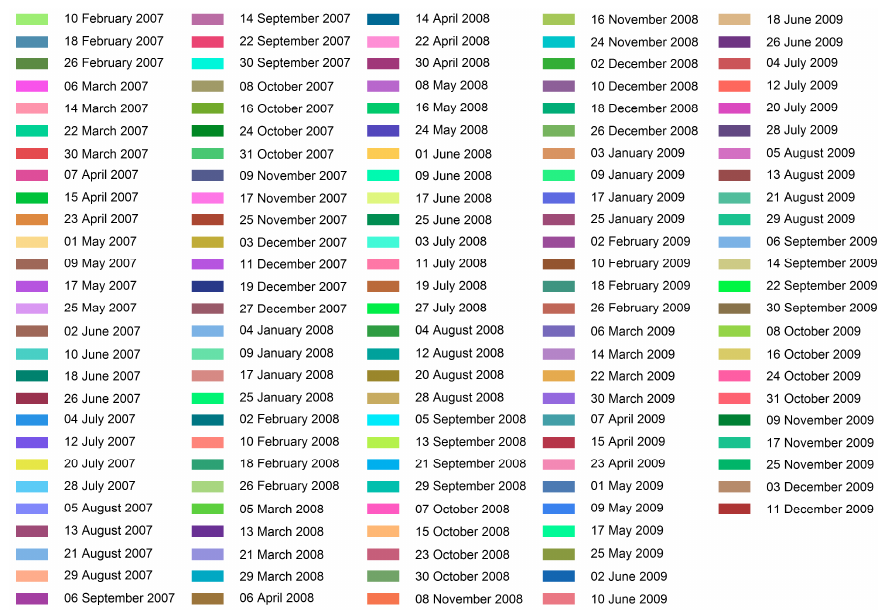
Figure A1. Color table for the Landsat disturbance detection results.